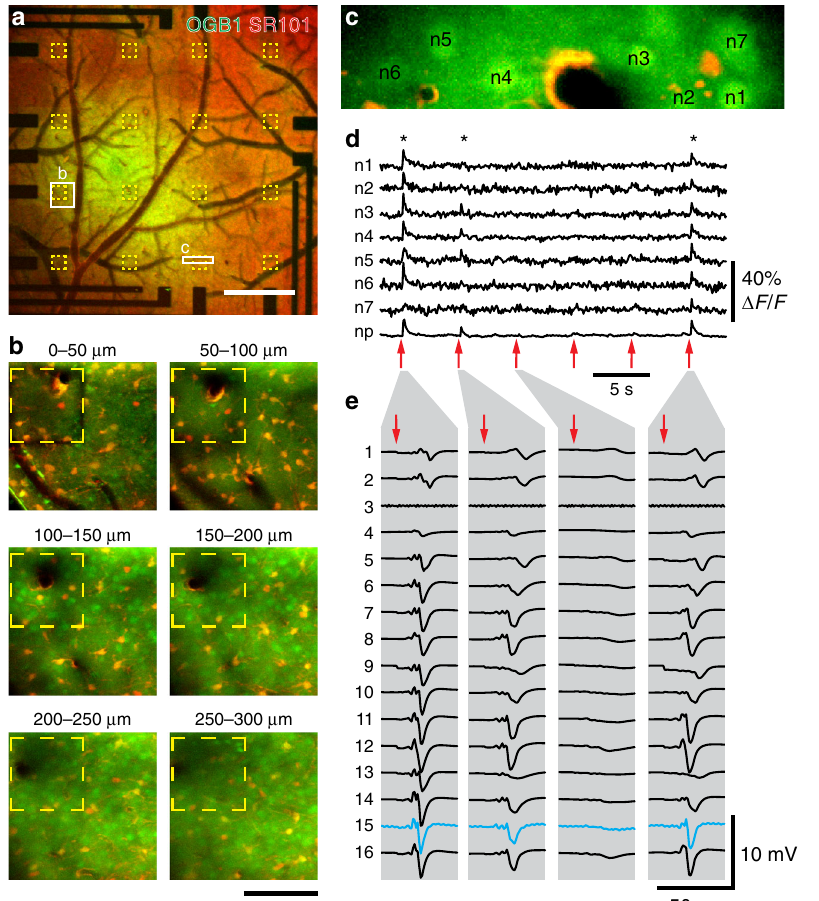
Fig. 3 Combination of 2-photon-based calcium imaging with electrical recordings. Before placement of the graphene microelectrode array, the calcium indicator Oregon Green 488 BAPTA-1 (OGB1) AM ester was pressure-microinjected and astrocytes were stained with Sulforhodamine 101 (SR101). a Overview image of OGB1 (green) and SR101 (red) staining below the graphene microelectrode array. Yellow outlines indicate single graphene electrodes, white rectangles indicate imaging sites shown in b and c . Scale bar, 500 µ m. b Two-photon imaging of OGB1 (green) and SR101 (red) below a single graphene electrode (yellow outline). Maximum intensity projections (MIPs) of images acquired at different depths (step size: 3 µ m) below the cortical surface are shown (MIP range indicated above individual images). Scale bar, 100 µ m. c Image of the region (size: 140 µ m × 32.6 µ m) used for functional Ca 2 + imaging as shown in d . In the center, a vessel (dark) passes the imaging plane. For analysis, images were segmented into individual neurons (n1 – n7; bright OGB1, no SR101 staining), astrocytes (bright OGB1 and SR101 staining), and neuropil (OGB1 staining, no SR101 staining). d Calcium traces (OGB1 fl uorescence change relative to pre-stimulus baseline, Δ F / F ) of individual neurons (n1 – n7 as shown in c ) and neuropil (np). Single electric stimuli (300 µ s, 1 mA) were delivered every 5 s (red arrows) to the whisker pad. Imaging was performed 150 µ m below the cortical surface at 12 Hz with 2-photon excitation at 800nm and a power of 50 mW. Asterisks (*) indicate “ responsive ” trials. e Corresponding electrical responses to electrical whisker pad stimulation (red arrow) measured with graphene microelectrode array; traces from four individual trials matching stimulations no. 1, 2, 3, and 6 in d are shown. Graphene electrodes are numbered 1 (top left in a ) to 16 (lower right in a ); electrode 3 is non-functional and 2-photon Ca 2 + imaging was performed right below electrode 15 (highlighted in blue), leading to slightly increased noise in this channel. Artifacts resulting from electrical stimulation were removed by linear